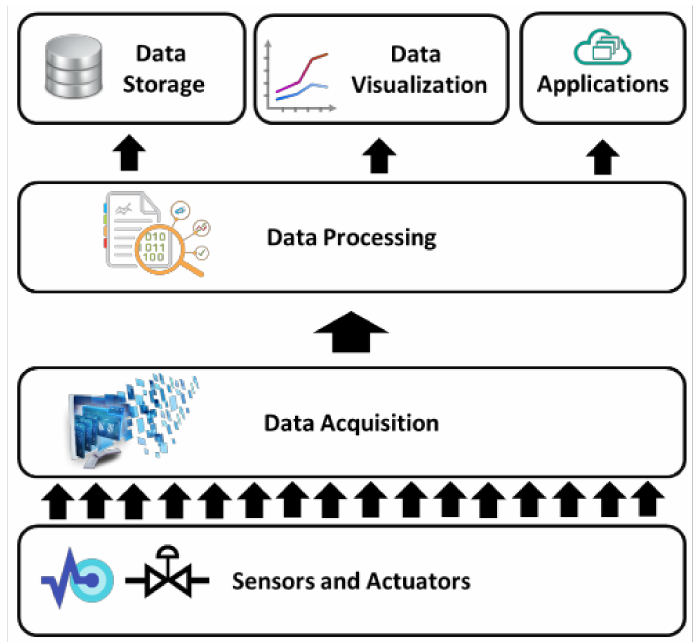
Figure 2. General architecture of an Internet of Things